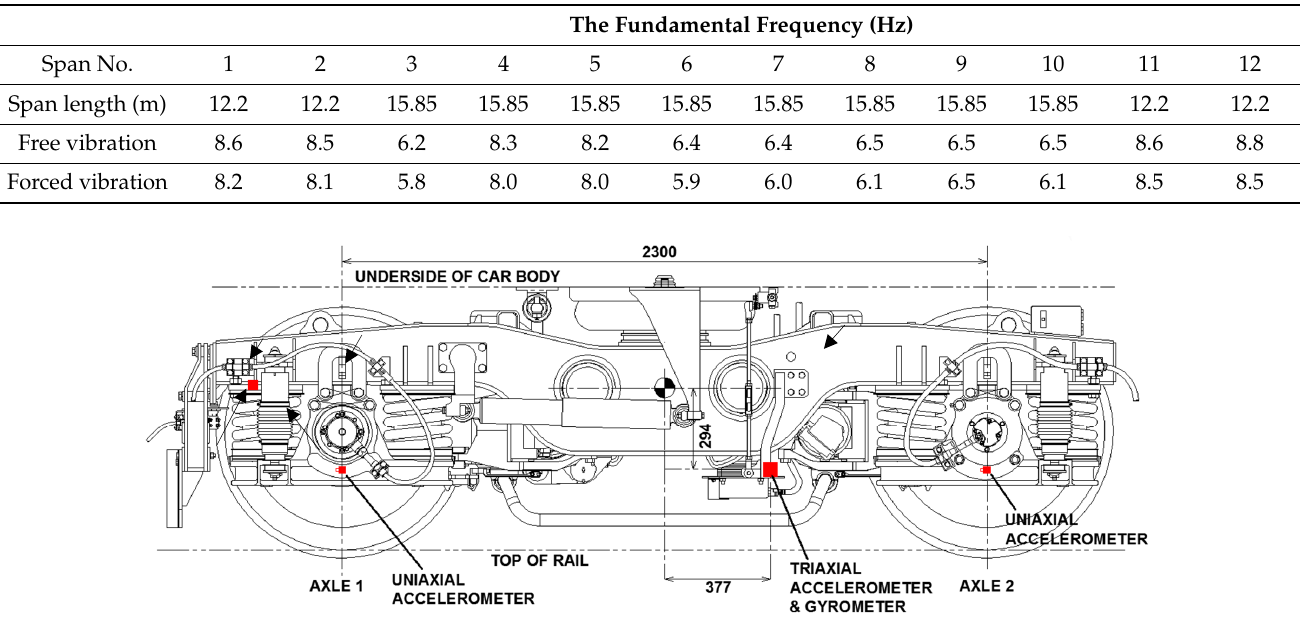
Figure 6. Layout of the sensors on an instrumented bogie of the train (dimensions in mm) taken from [55].